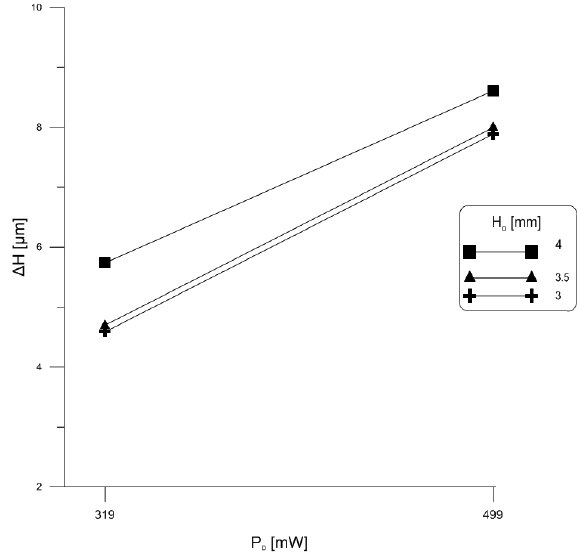
Figure 6. Wire flexure as a function of power.